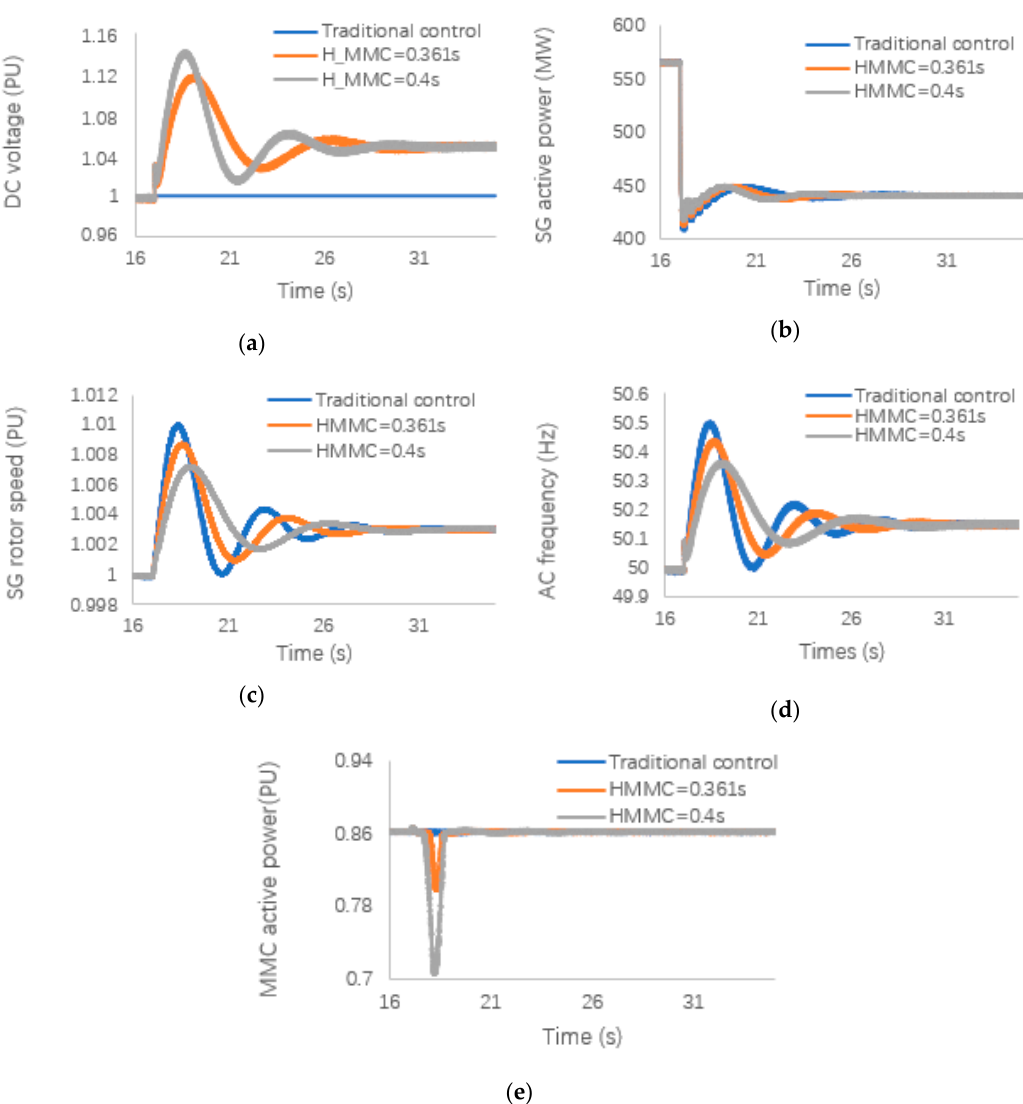
Figure 5. E ff ective short circuit ratio (ESCR) is 1.7 for 10% load decrease: ( a ) DC voltage; ( b ) synchronous generator (SG) active power; ( c ) SG rotor speed; ( d ) AC system frequency; ( e ) modular multilevel-converter (MMC) active